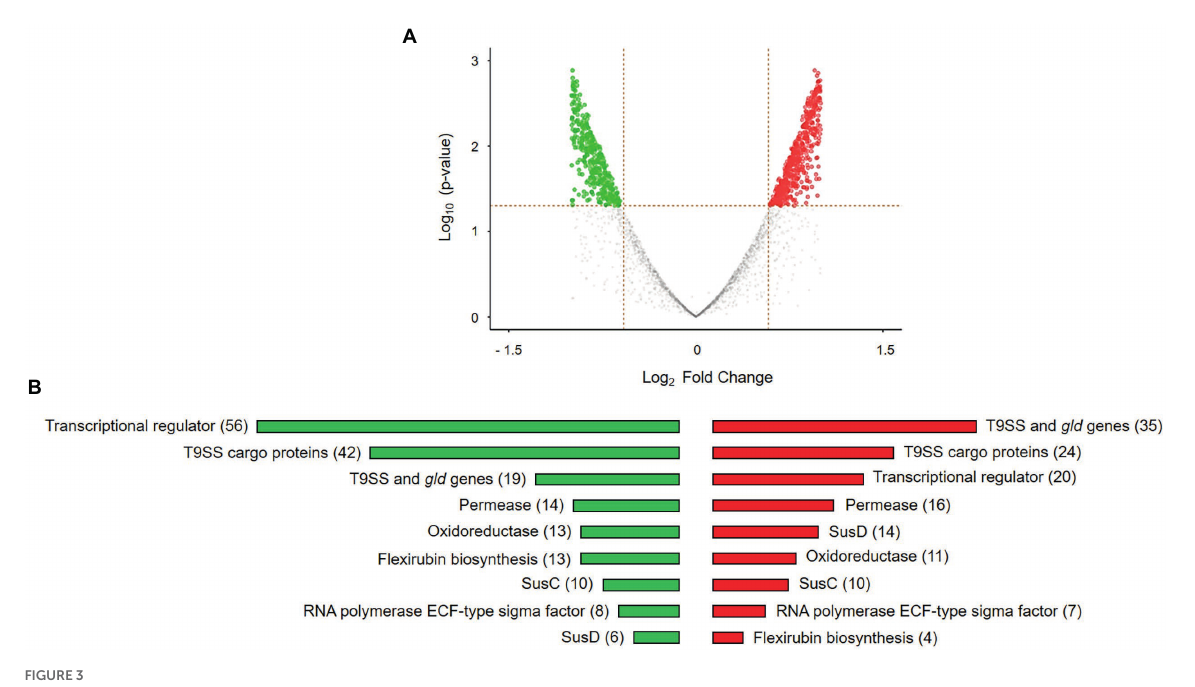
FIGURE 3 DEGs in Dyadobacter sp. HH091 co-cultured with M. radians MZCH 672 compared with control dataset. (A) Volcano plot is highlighting the DEGs in Dyadobacter sp. x-axis: log2, large-scale fold changes; y-axis: –log10 of the value of p showing the statistical significance. Each point corresponds to one gene. The points above the vertical and horizontal dotted lines represent log2FC ≥ 0.58 and value of p < 0.05. A volcano plot was generated using A Shiny app ggVolcanoR. (B) Function profile of differentially expressed genes (DEGs) in Dyadobacter sp. HH091 is presenting the groups of highly active genes. Total number of genes are shown in brackets. Color key: up-regulated genes, down-regulated